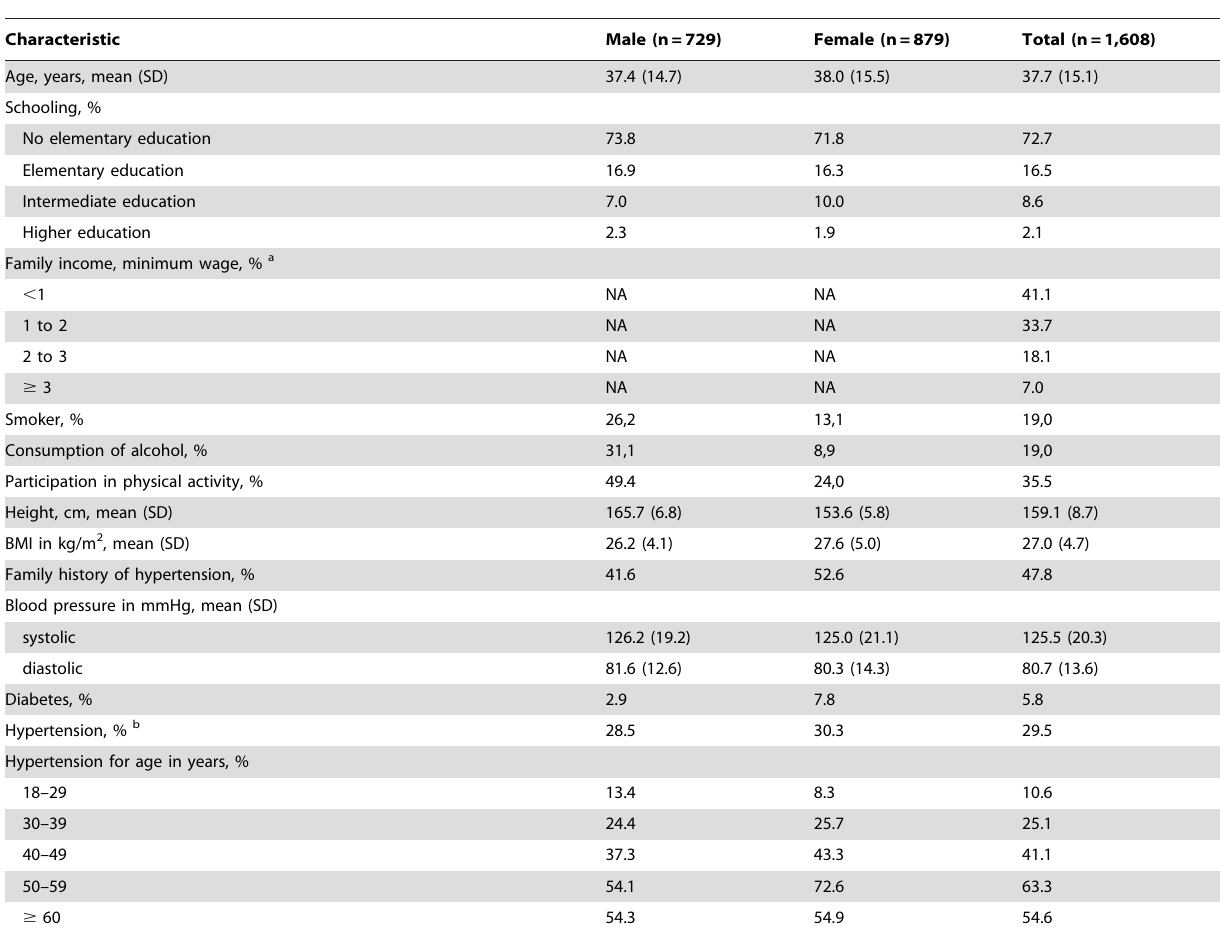
Table 1. Socioeconomic, demographic, and clinical characteristics of the study